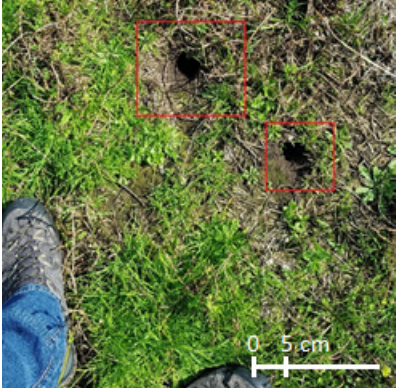
Figure 3. Photo of oval-shaped burrow holes, marked in red rectangles, taken with a smartphone camera from a height of 1 m.